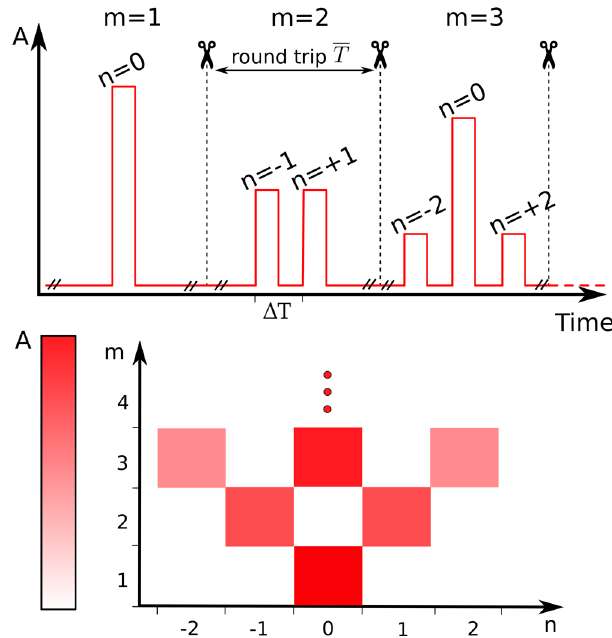
Fig. 6 Schematic representation of the protocol used to reconstruct the space – time diagram showing the evolution of light pulses in the Floquet – Bloch lattice by starting from the time signal recorded by a photodiode at the output of the double loop system. The recorded signal is sliced in a sequence of multiple time windows having all a duration (cid:2) T equal to the mean round trip time of light in the double loop system. The space – time diagram is recomposed by concatenating the multiple time slices and by encoding the amplitude of the square pulses using a colormap. The index n provides the position of the light pulses at the m th round trip in the Floquet – Bloch lattice. A is the amplitude of the detected signal. The vertical color bar indicates the mapping from the amplitude A to